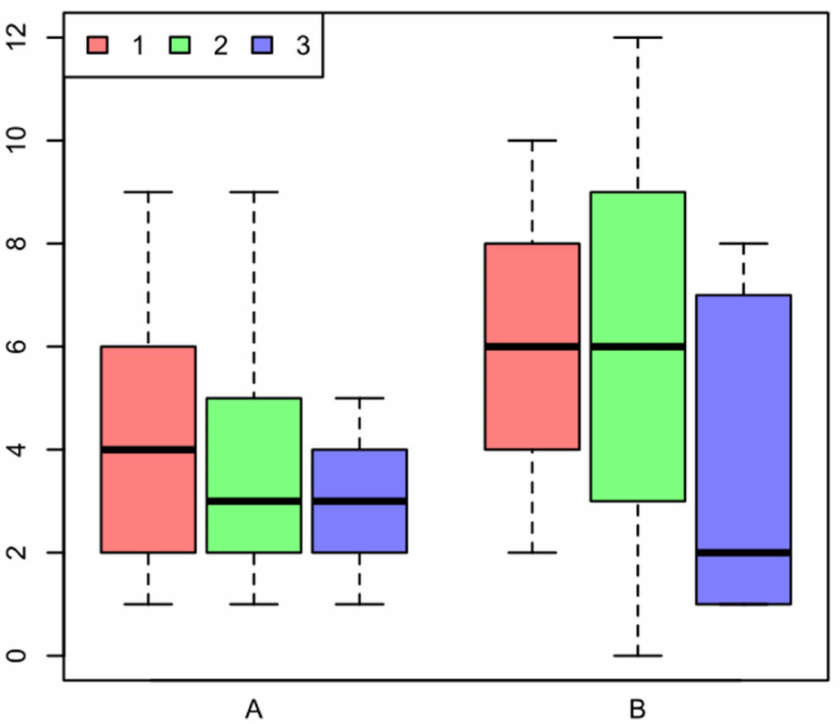
Figure 5. Example of clustering population comparison by using boxplots in terms of two variables (A and